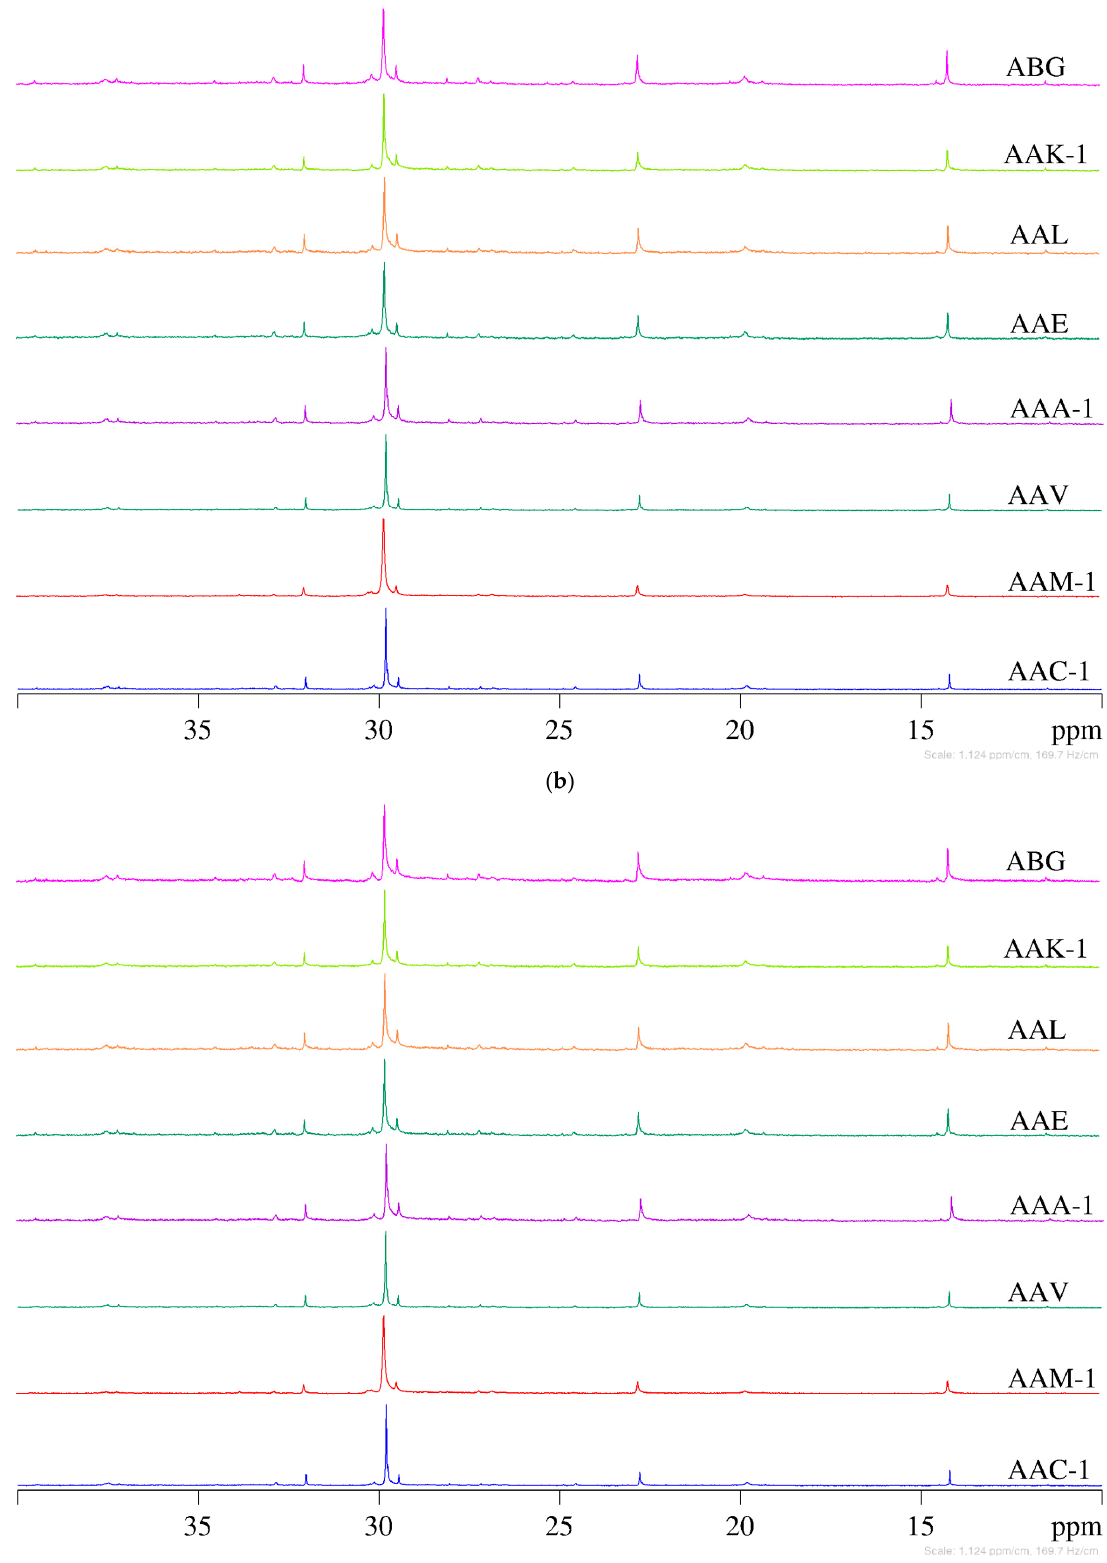
Figure 1. 13 C NMR spectra of SHRP asphalt binders. ( a ) Unaged, ( b ) 20 h PAV, and ( c ) 60 h